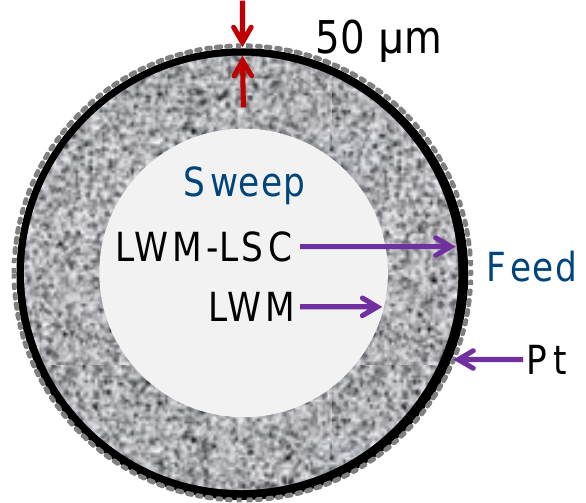
Figure 7. Configuration with inner sweep.